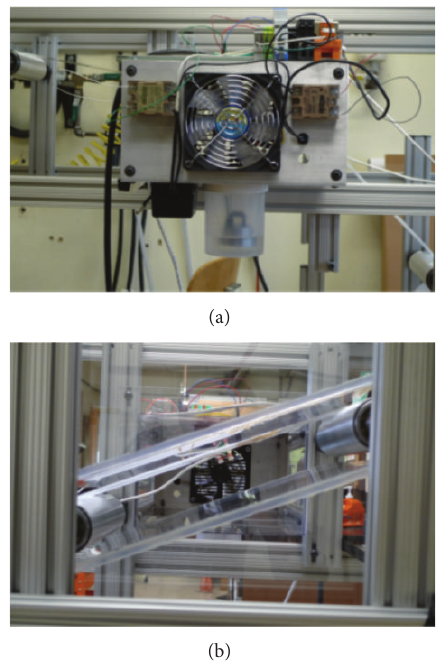
Figure 6: Upstream (a) and downstream (b) of a temperature- humidity controlled drying